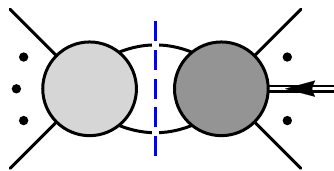
Figure 1 . Unitarity cut relevant for the extraction of anomalous dimensions from one-loop form factors. The darker blobs indicate a higher-dimension operator insertion. The double-lined ar- row indicates the insertion of additional o(cid:11)-shell momentum from the operator. The dashed line indicates the integral over phase space of the particles crossing the